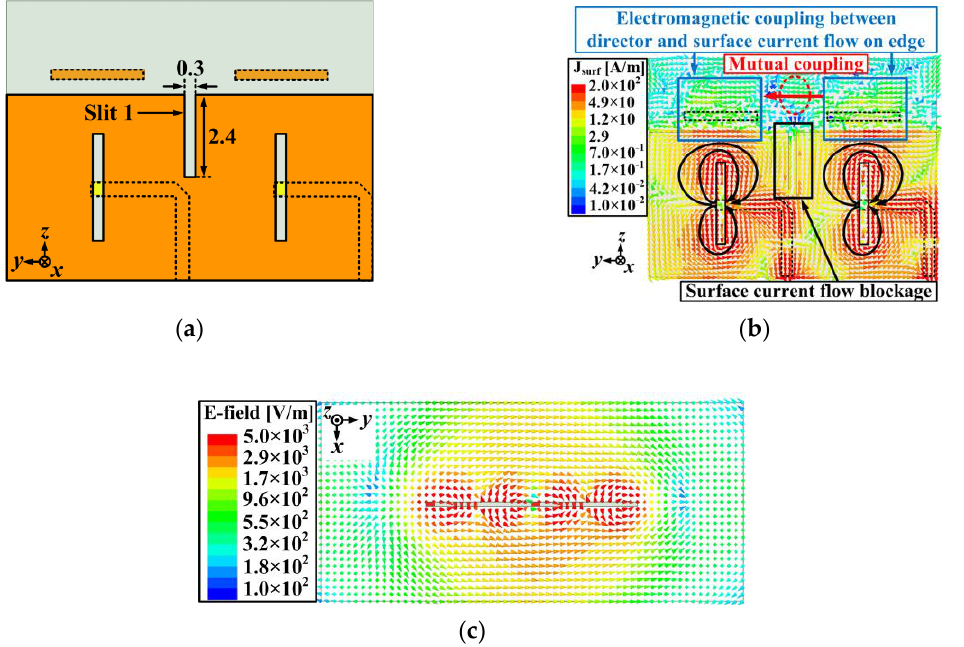
Figure 10. The 1 × 2 array antenna with only Slit 1: ( a ) top view, ( b ) simulated surface current distribution at 28 GHz, and ( c ) simulated E-field distribution in the E-plane at 28 GHz.